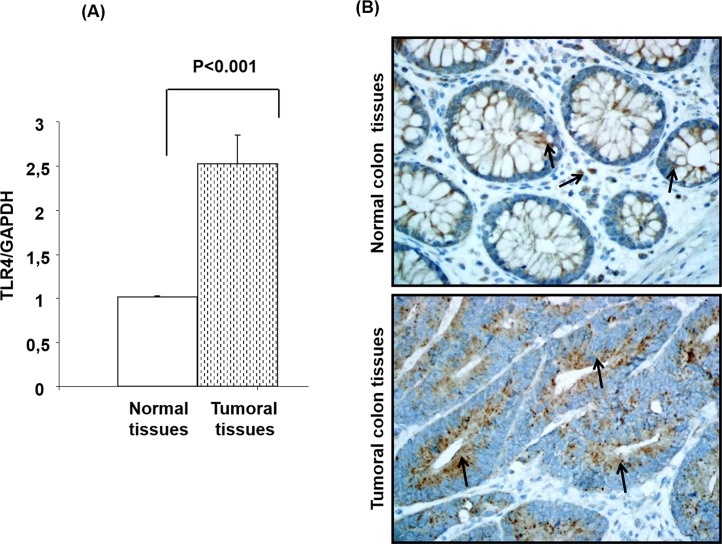
Toll-Like-Receptor 4 (TLR4) mRNA and protein expression in colon cancer tissues.Total cellular RNA freshly extracted from matching normal and colon cancer tissues was reverse transcribed into cDNA and then used to measure the TLR4mRNA expression (Panel A). Tissues were immunostained using specific TLR4 antibody (Panel B).